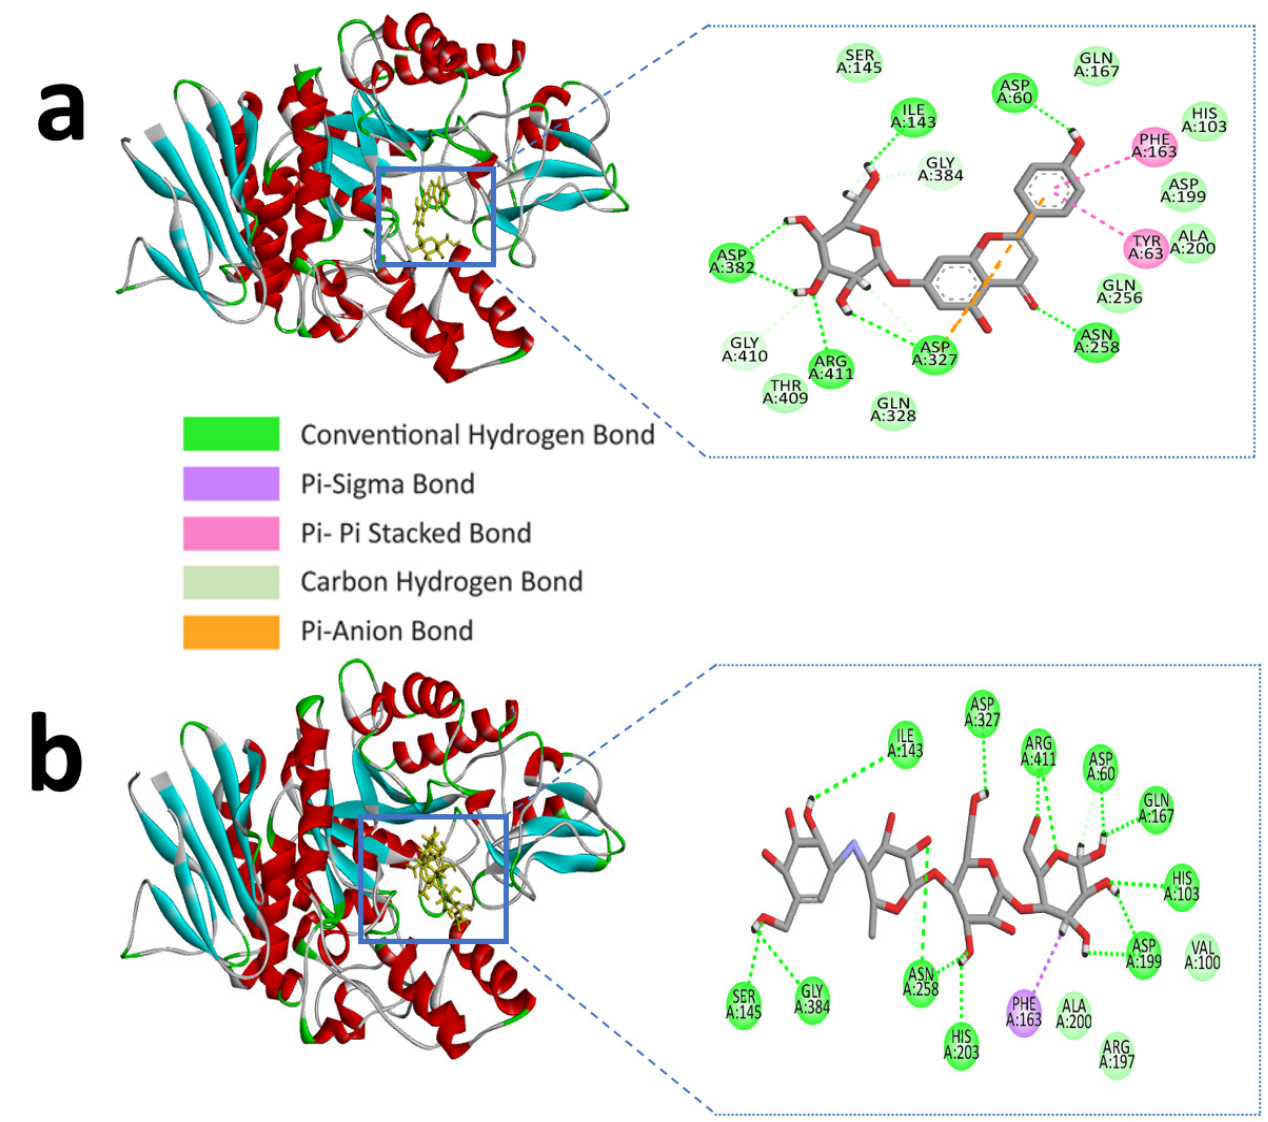
Figure 2 . Molecular interactions of the selected compound with alpha ‐ glucosidase, ( a ) apigenin ‐ 7 ‐ Figure 2. Molecular interactions of the selected compound with alpha-glucosidase, ( a ) apigenin-7- O - O ‐ glucoside with alpha ‐ glucosidase, ( b ) control acarbose with alpha ‐ glucosidase. glucoside with alpha-glucosidase, ( b ) control acarbose with Table 2. Data for the molecular docking of apigenin ‐ 7 ‐ O ‐ glucoside, luteolin ‐ 7 ‐ O ‐ glucoside, querce ‐ tin, and control acarbose with alpha ‐ glucosidase (3W37) .